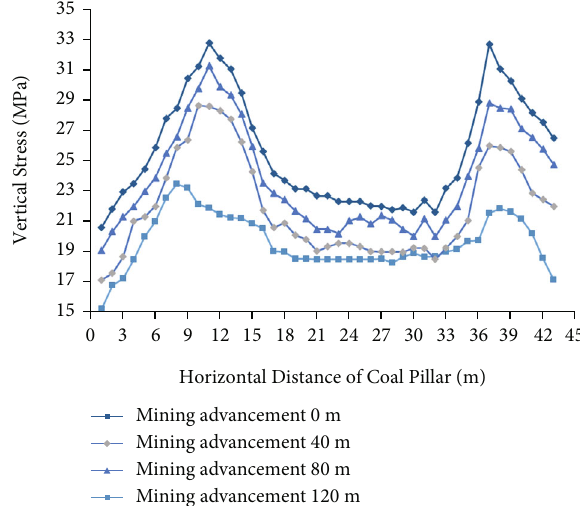
Figure 10: Vertical stress distribution curve of coal pillar during 4102 working face advancing.